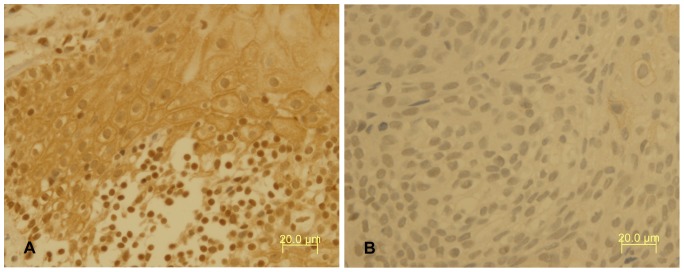
Immunohistochemical staining of PER1 protein expression in tissues of patients with BSCC.A: PER1 was strongly positive in the adjacent noncancerous tissues. B: PER1 was positive or weakly positive in cancerous tissues (magnification, ×400).